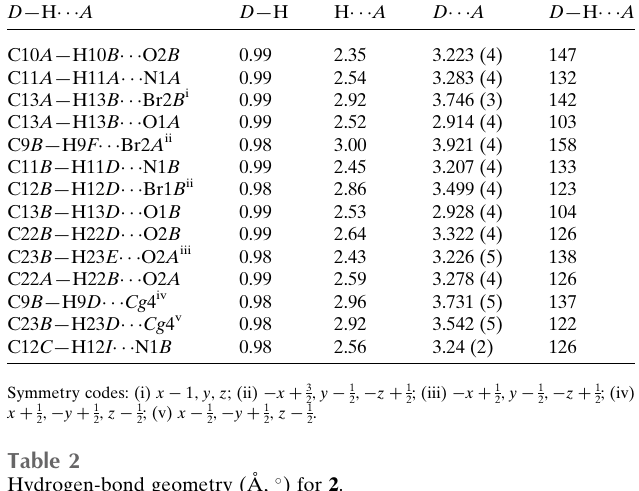
Table 1 Hydrogen-bond geometry (A˚ , (cid:3) ) for 1 . Cg 4 is the centroid of the C15 B –C20 B ring.